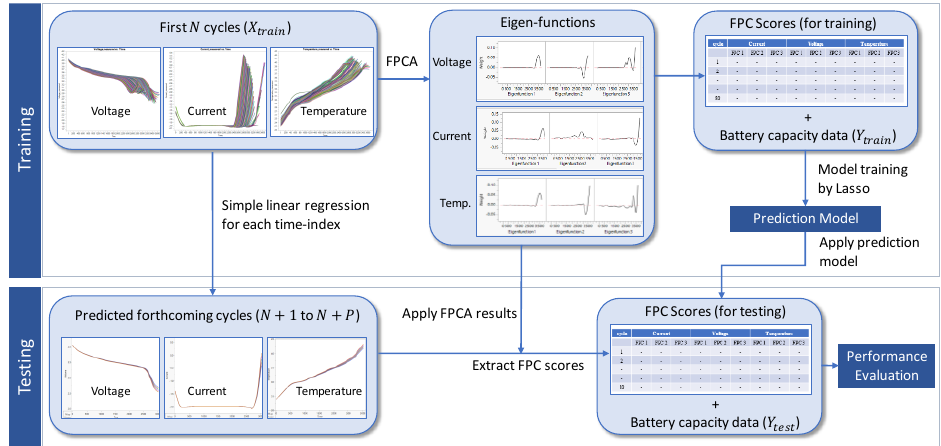
Figure 1. Graphical representation of workflow.